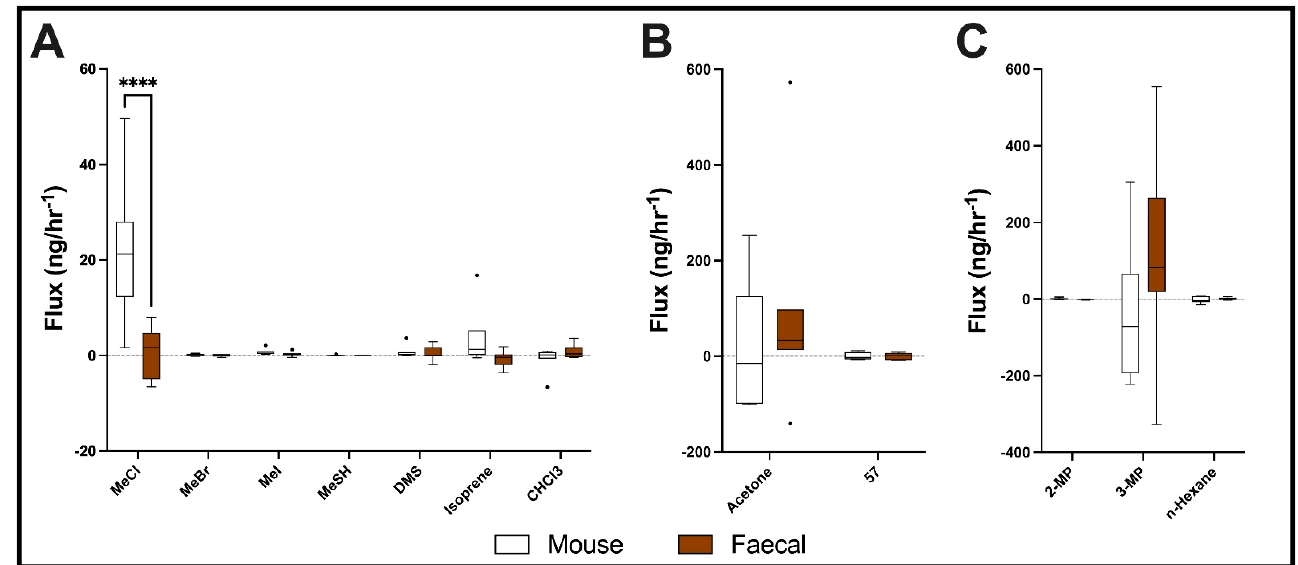
Figure 4. Volatile organic compounds from mouse breath and faecal material. (A-C) Boxplot for select volatile organic compounds from chambers with single mice vs. chambers with mice removed and faecal material. Flux in g/h (median ± Tukey distribution; n = 6 mice across 3 separate cages). ANOVA followed by Bonferroni hoc test was performed; **** p < 0.0001.